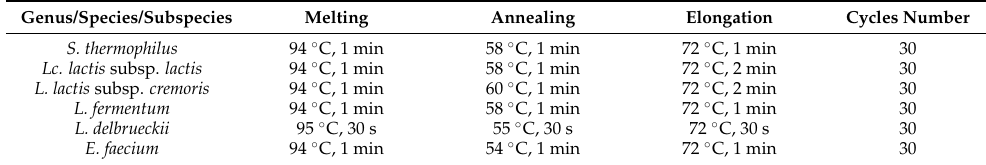
Table 2. Species- and subspecies-specific PCR